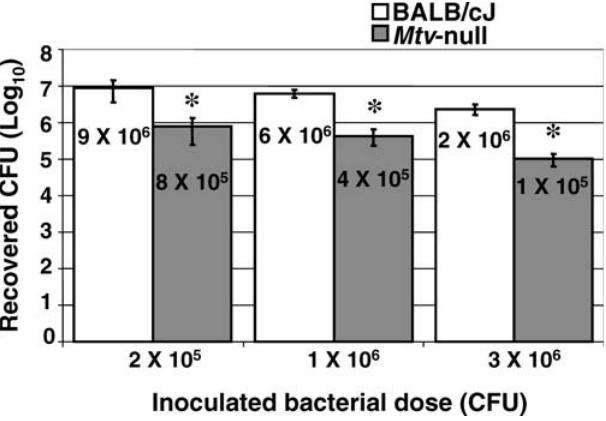
Figure 5. Bacterial Load Is Decreased in Mtv -Null Mice Three different doses of V. cholerae were given to 5- to 6-d-old pups (three to four animals/dose). After 24 h, the mice were sacrificed, and the small intestines were assayed for bacterial growth. The means (numbers shown inside bars) and standard deviations for the recovered CFUs of each set of animals are indicated. Two-tailed Student’s t tests were used for pair-wise comparisons of BALB/c and Mtv -null animals infected at each dose; p -values of , 0.05 are shown by an asterisk.